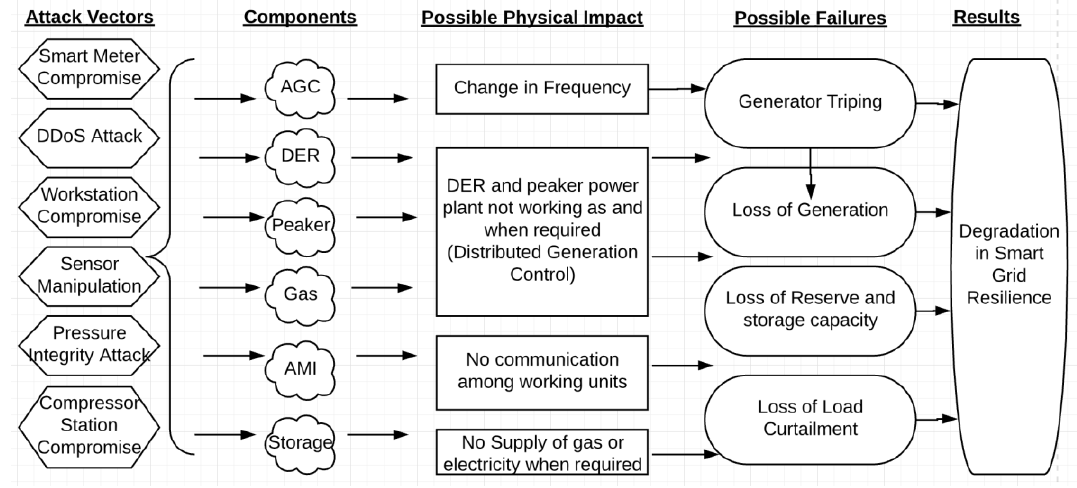
Figure 1. Smart grid resilience graph. AGC, Automatic Generation Control; AMI, Advanced Metering Infrastructure.